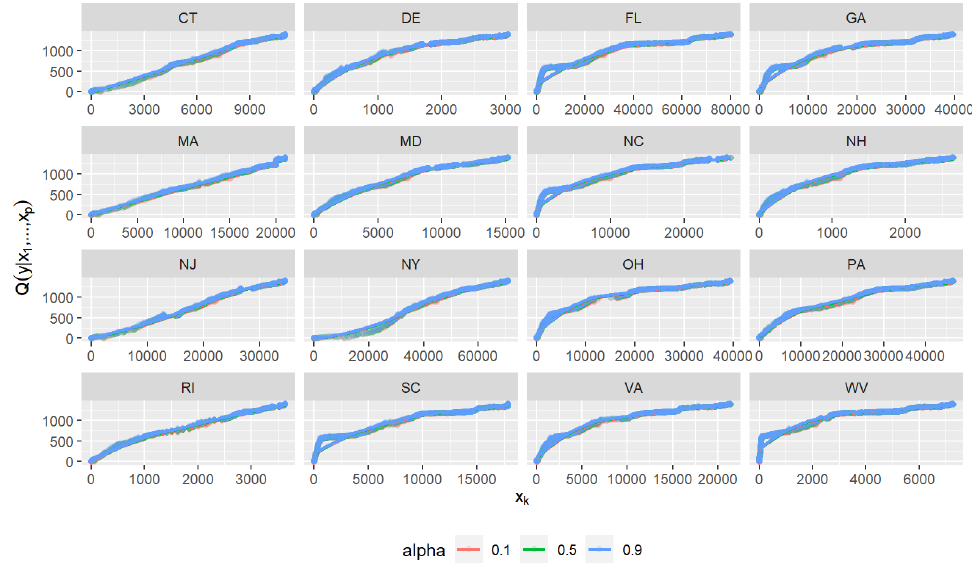
Figure 6. Plots of marginal effects of a D-vine quantile regression model (10%, 50%, 90%) for DC on the COVID-19 daily cumulative mortality data for CT, DE, FL, GA, MA, MD, NC, NH, NJ, NY, OH,